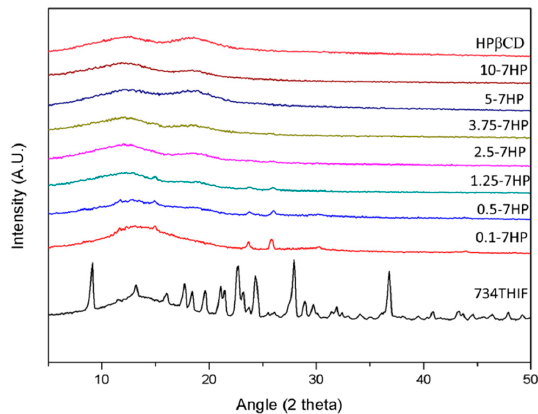
Figure 3. Powder X-ray diffraction patterns of HPBCD, different ratios of 734HP, and raw 734THIF.